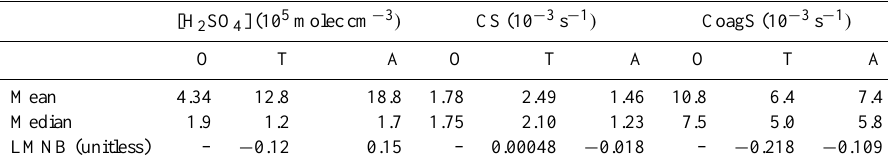
Table 4. Mean, median, and bias values for three nucleation metrics specific to Hyyti¨al¨a (due to data availability). O = observed, T = ternary simulation, A = activation simulation.